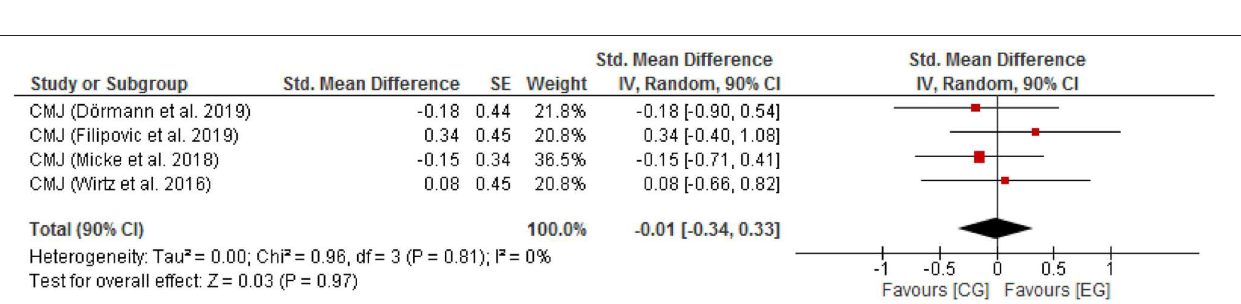
FIGURE 4 | Counter Movement Jump for CG vs. EG; SE, standard error; CI, confidence interval; Std., standardized; IV, independent variable.